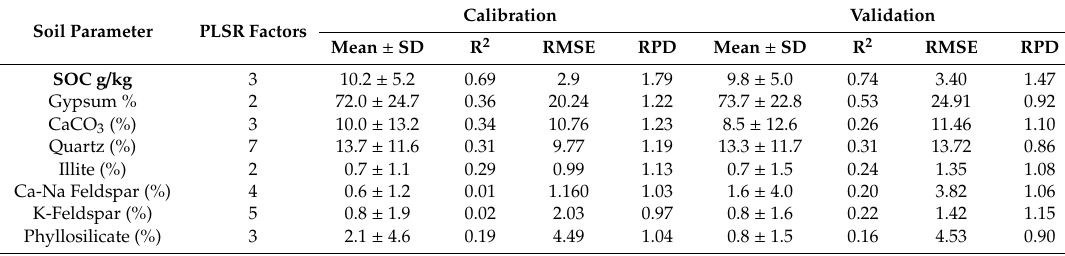
Table 3. Calibration and cross-validation results of selected partial least squared regression (PLSR) analysis after data transformations and pre-processing. (RMSE = root mean square error; RPD = relative percent deviation). The PLSR factors are the number of factors that produce the minimum RMSE and maximum R 2